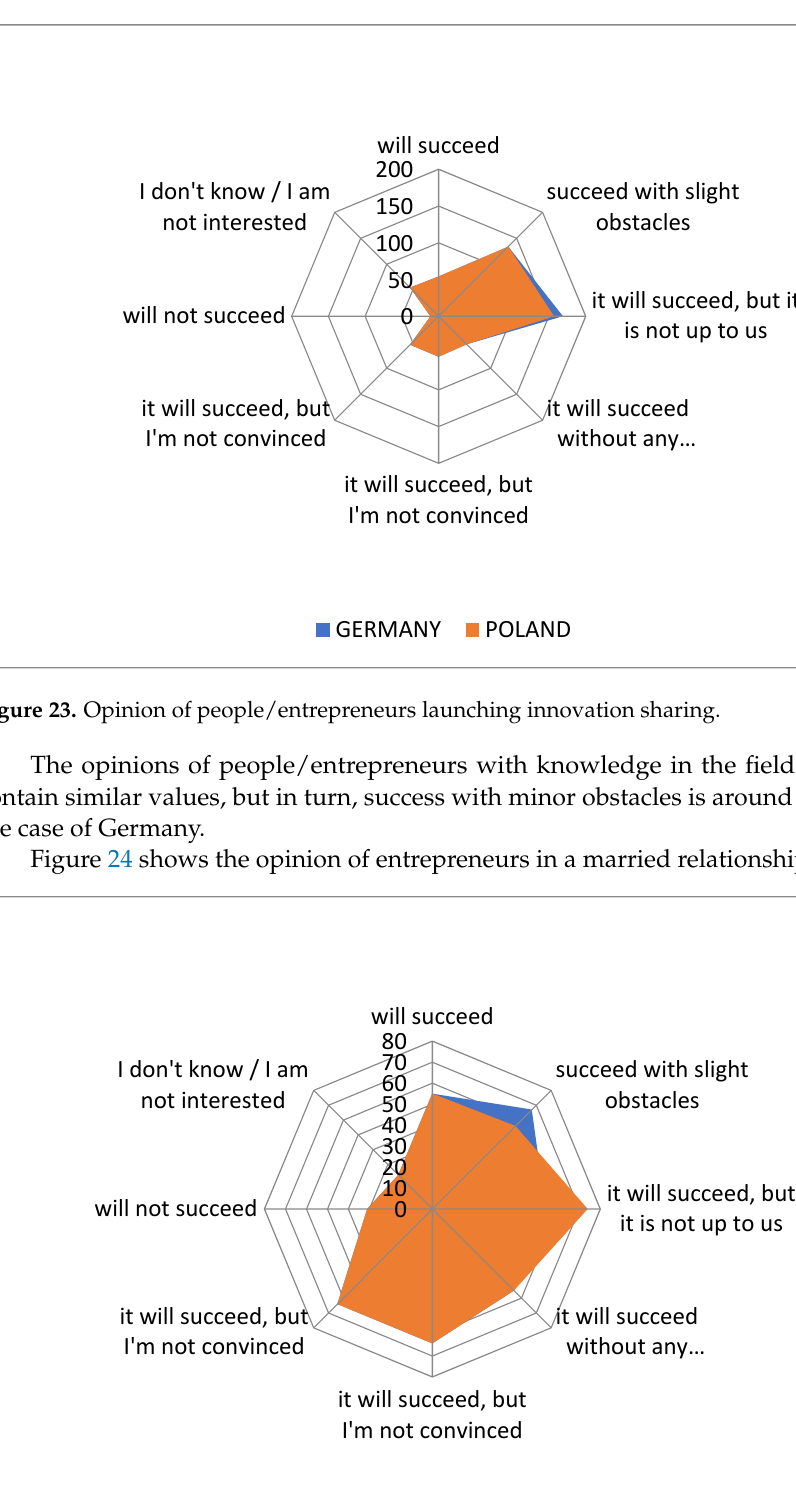
Figure 22. Opinions a natural person independent (without a couple).